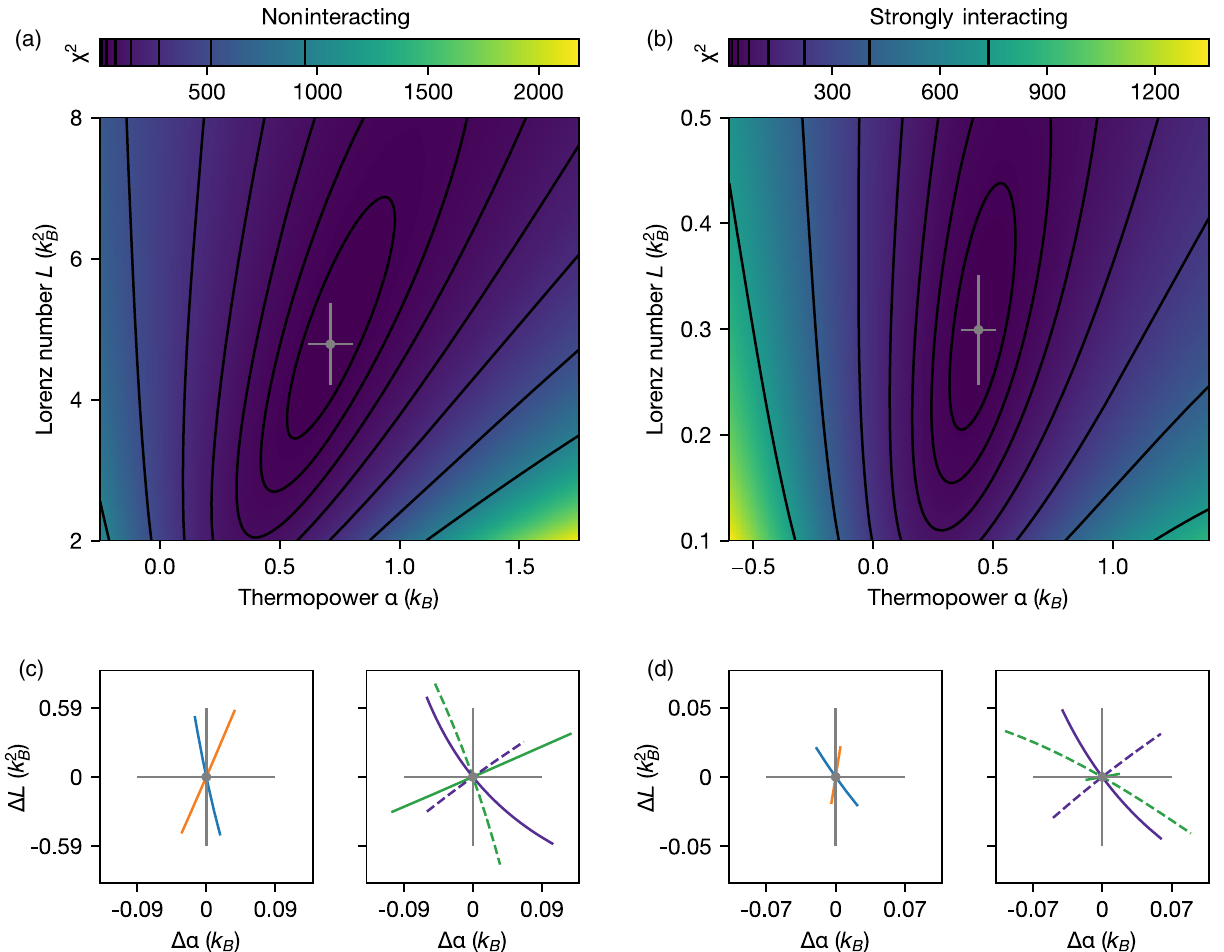
FIG. 5. Transport parameter estimation. (a,b) Sum of squared residuals χ 2 versus effective thermopower α and Lorenz number L in the 0 . 13 μ K. Contour lines highlight the behavior at logarithmically spaced (a) noninteracting and (b) strongly interacting regimes at V g ¼ level values indicated by vertical black lines in the color bar. The offset Δ T in the temperature difference is fixed to the fitted value. off The optimal fit parameters and uncertainties are indicated by the point and the error bar, respectively. (c,d) Variations of the optimal thermopower and Lorenz number when one fixed fit parameter is changed within its uncertainty (colored lines). Left panel: modifications in conductance (orange) and compressibility (blue). Right panel: modifications in initial values Δ N 0 (solid green), Δ T 0 (solid violet), and the offsets Δ N (dashed green) and Δ T (dashed violet). Changes in the thermodynamic analogue of the Lorenz off off number l are too small to be